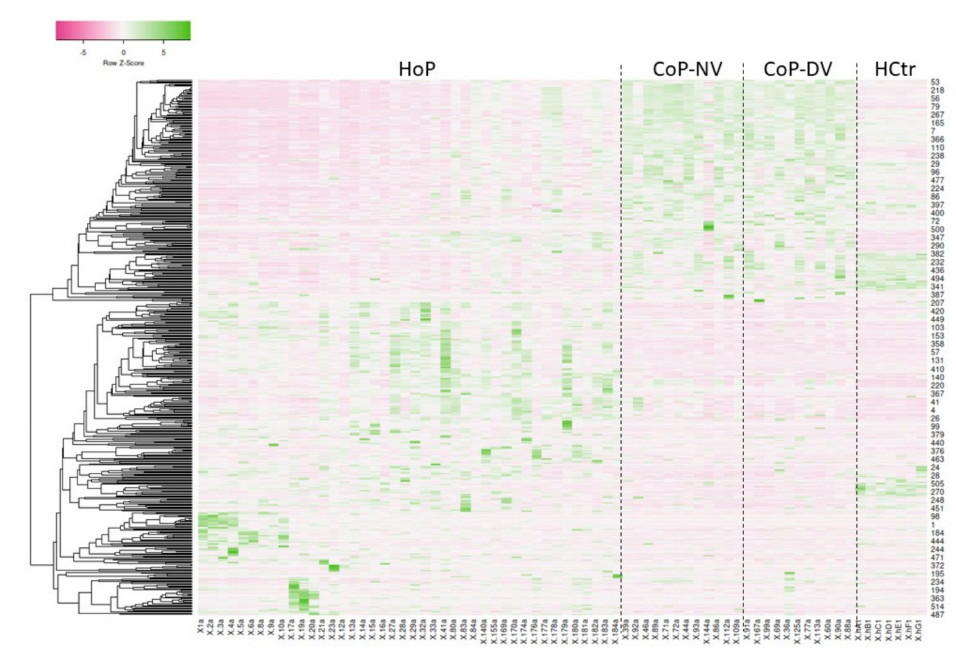
Figure 2. Heatmap of shortlisted results from HDMS-based expression analysis (accumulated ion intensities, protein assignment by at least two peptides, fold value > 2, ANOVA p ≤ 0.05; Pearson distance measurement). Shown is sample label vs. protein